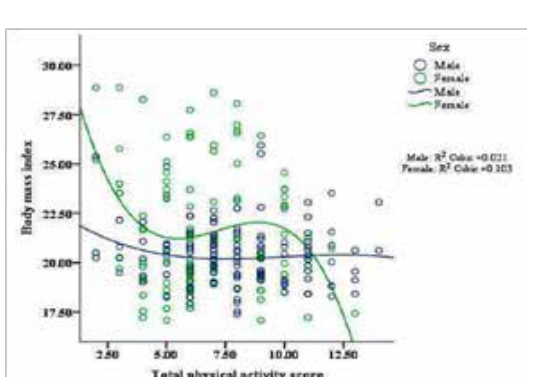
Fig 1. Relationship of physical activity score with BMI